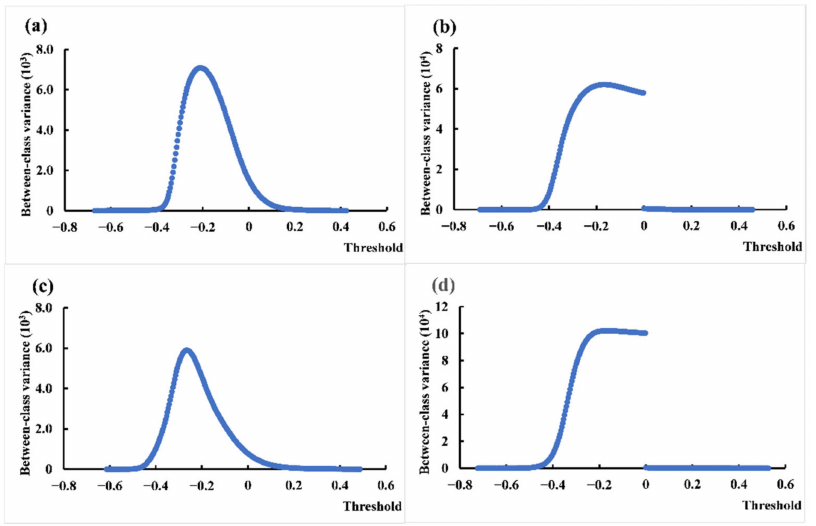
Figure 6. Comparison of thresholding selection. The peak between-class variance corresponds to the optimal threshold value. Panels ( a , c ) are Otsu-based thresholds selected in training area and